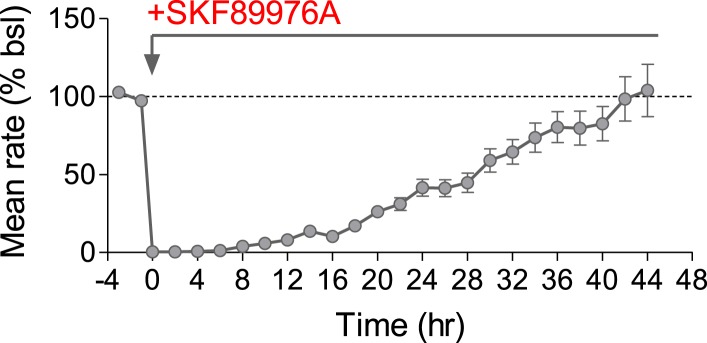
Effect of GABA uptake inhibitor on mean firing rate.Mean firing rate is decreased by 10 μM SKF89976A, a selective GAT-1 blocker, and fully recovers after 2 days (n = 46 units).